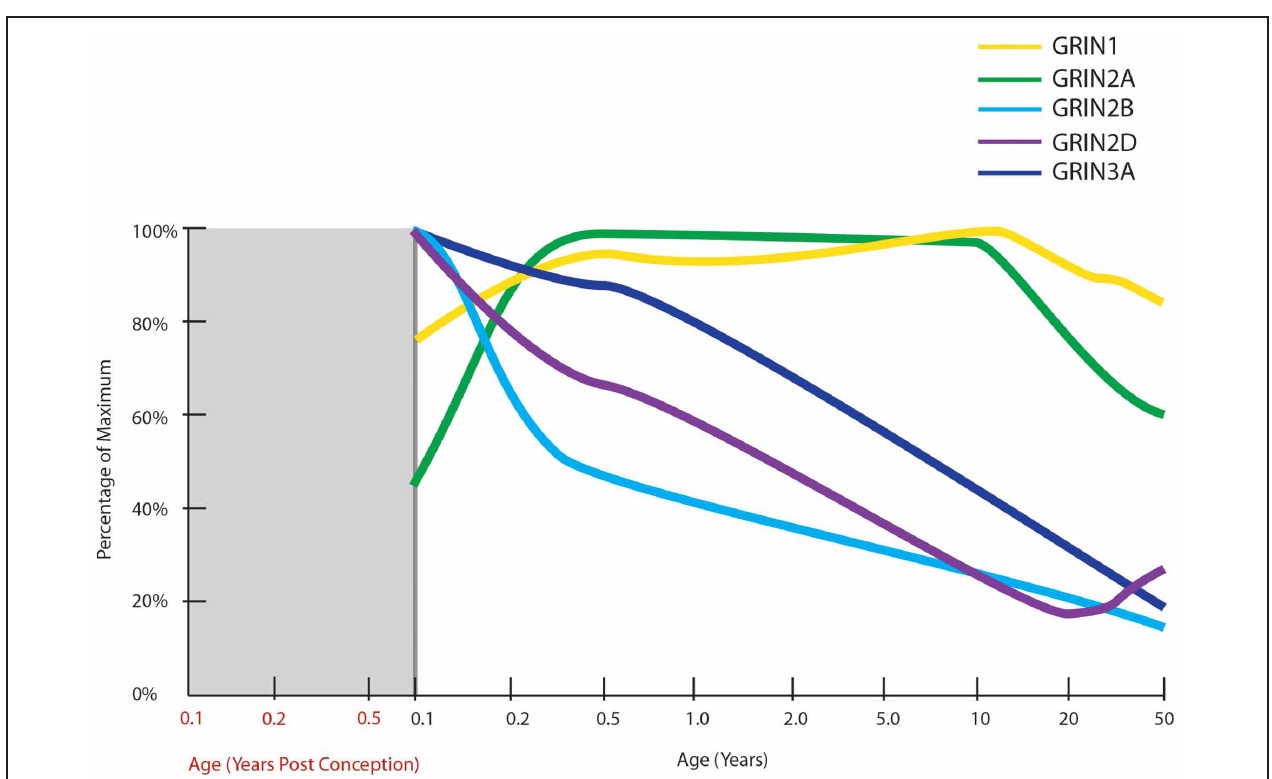
until middle age. GRIN2A expression increases in infancy to attain fairly steady levels throughout childhood and then decreases through adolescence and into adulthood. GRIN2B, GRIN2D, and GRIN3A all have their highest expressions at birth with decreasing trajectories